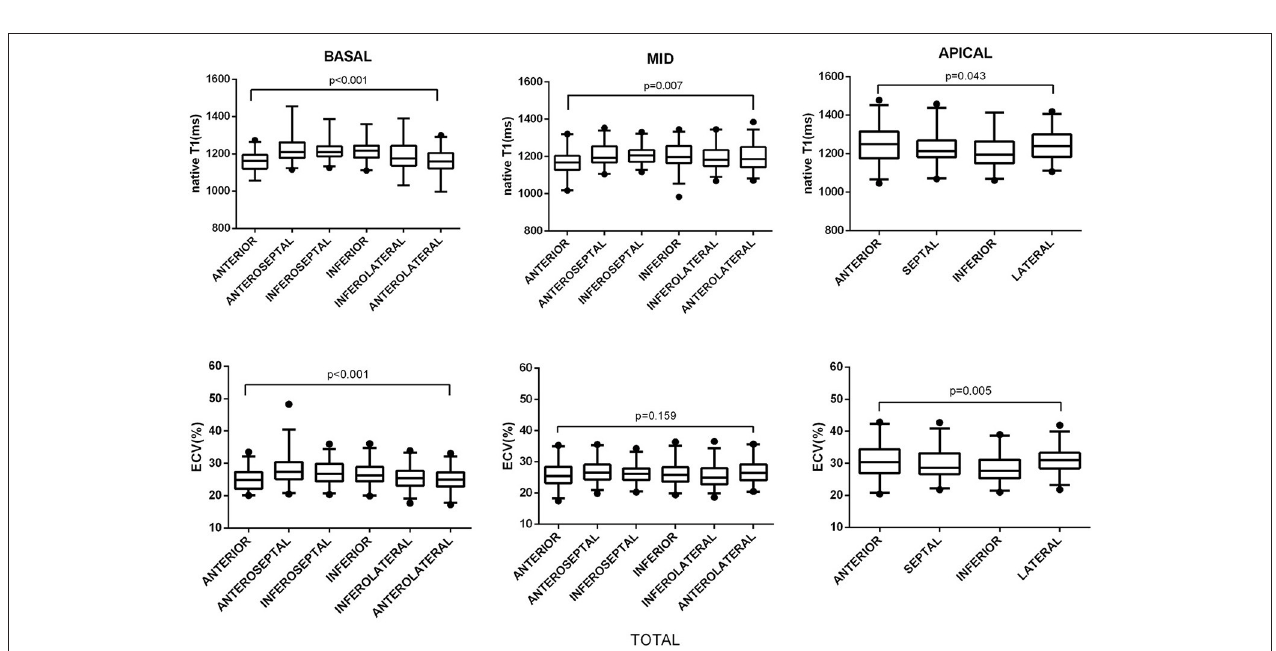
FIGURE 1 | Native T1 value and ECV (median and interquartile range) in AHA 16 segments displayed by bull’s eye model, by gender. Native T1 (ms) value (A) and ECV (%) value (B) in AHA 16 segments.